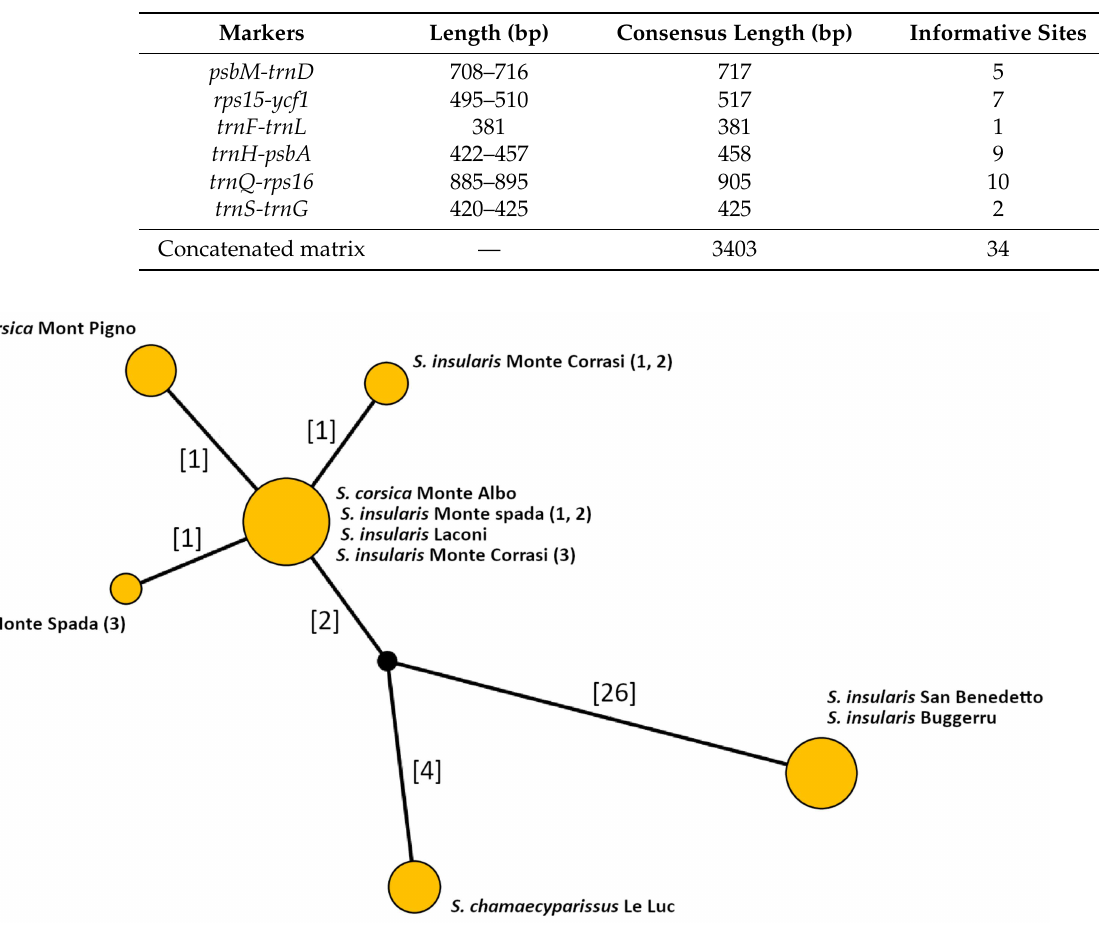
Figure 2. Haplotype network based on the cpDNA markers listed in Table 2. The yellow circles represent groups of Santolina individuals sharing the same haplotype, while the numbers in square brackets are the number of mutational steps among different haplotypes. The black circle is a non-sampled haplotype, hypothesized by the algorithm, connecting the three haplotype